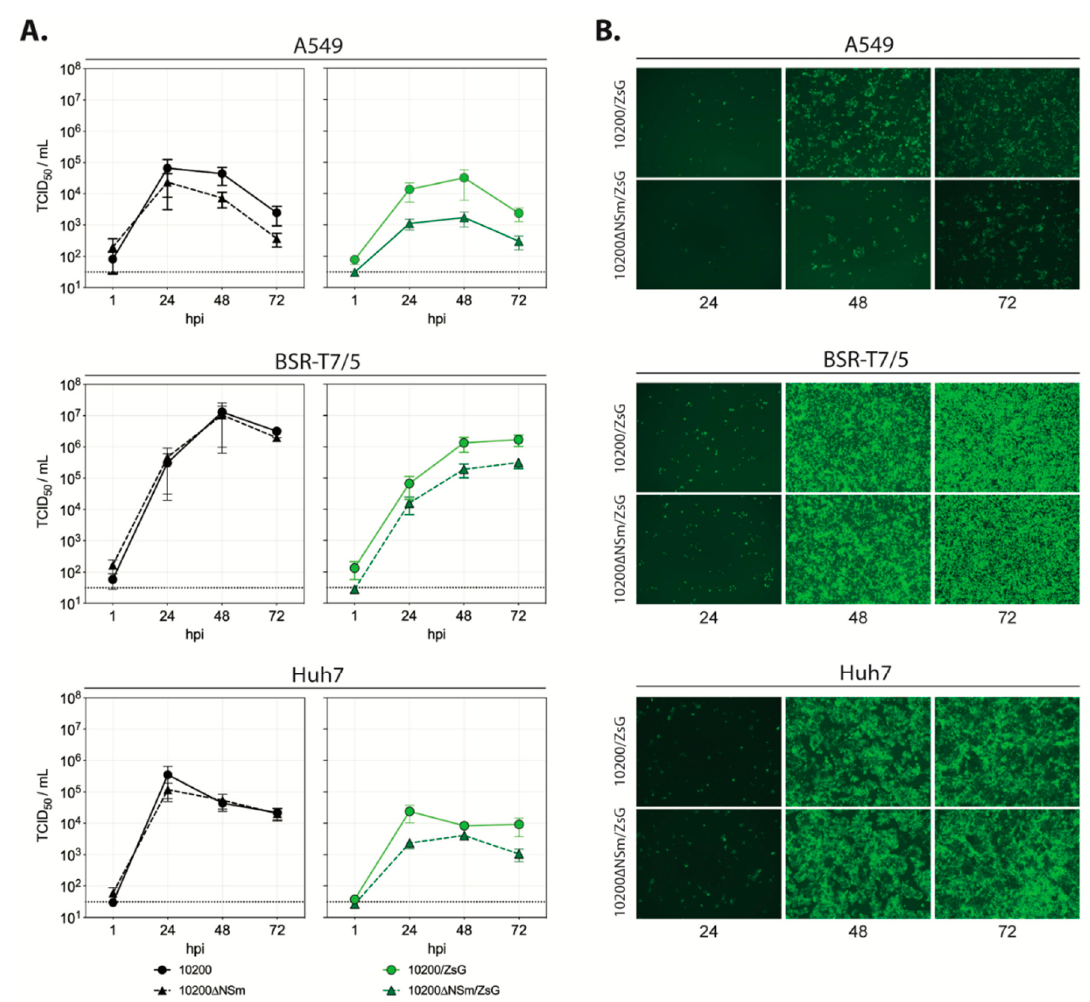
Figure 2. In vitro characterization of recombinant 10200 variants. ( A ) Growth kinetics of 10200 (black circle), 10200 ∆ NSm (black triangle), 10200 / ZsG (green circle), and 10200 ∆ NSm / ZsG (green triangle) recombinant CCHF viruses in A549, BSR-T7 / 5, or Huh7 cells infected at a multiplicity of infection (MOI) of 0.1. Cells were incubated with virus inoculum for 1 h and washed once with PBS before fresh media was added. Titers (TCID 50 / mL) were determined at the indicated timepoints. Represented are the mean and standard deviation of triplicate experiments (each individual experiment n = 3). ( B ) A549, BSR-T7 / 5, or Huh7 cells infected with either 10200 / ZsG or 10200 ∆ NSm / ZsG at an MOI of 0.1 were imaged 24, 48, and 72 h post infection using fluorescent microscopy examining ZsG expression levels (images shown are at × 10